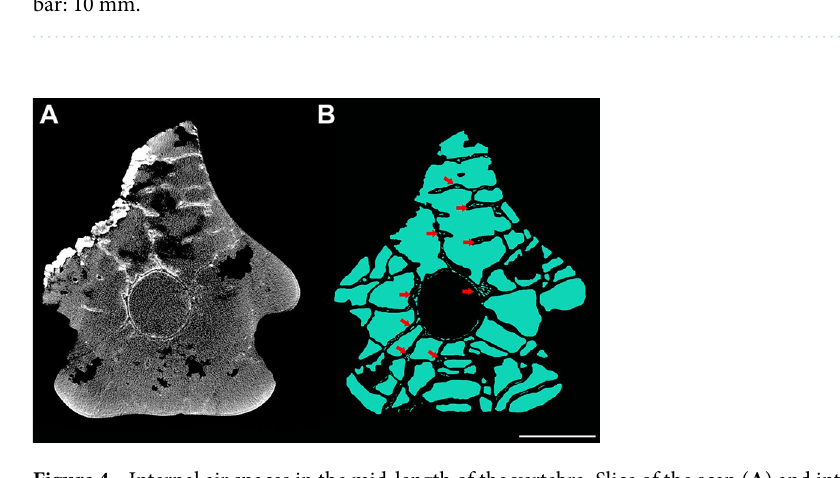
Figure 4. Internal air spaces in the mid-length of the vertebra. Slice of the scan ( A ) and internal air spaces marked in blue ( B ) in the mid-length of the vertebra of the sixth cervical vertebrae of SNSB/BSPG 1991 I 27. Red arrows indicate small hollow cavities within the bone trabeculae. Scale bar: 10